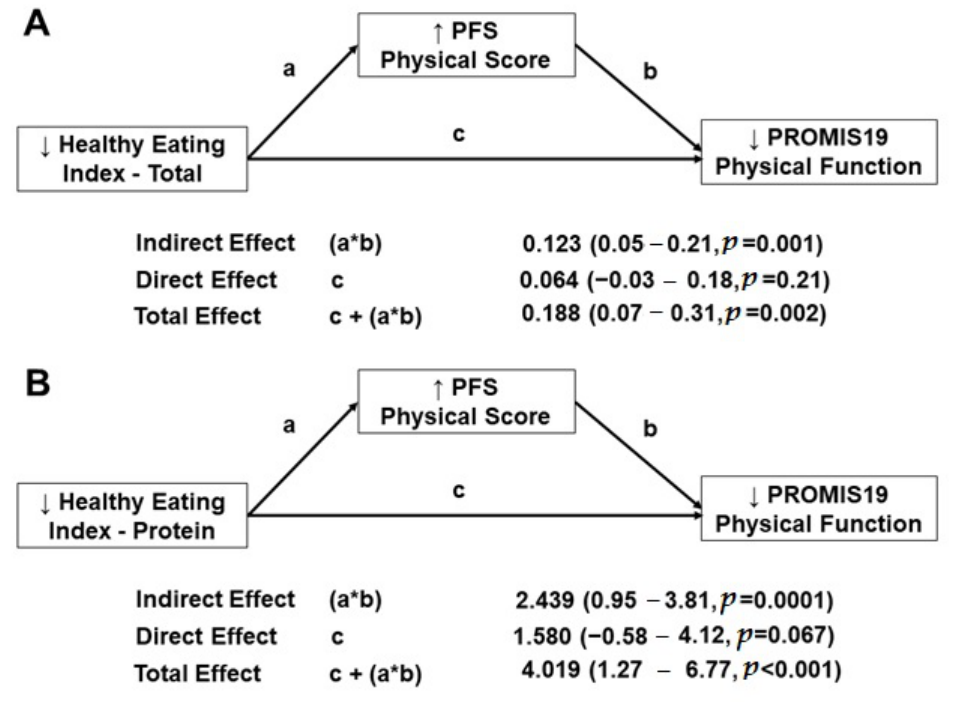
Figure 2. ( A ) shows the statistical mediation analysis for the associations of the lower Healthy Eating Index, more self- reported physical fatigability, on lower self-reported physical function through in a subset of 122 oldest-old participants from the Geisinger Rural Aging Study. ( B ) shows the statistical mediation analysis for the associations of the lower Healthy Eating Index—protein, more self-reported physical fatigability, on lower self-reported physical function through in a subset of 122 oldest-old participants from the Geisinger Rural Aging Study. The dependent (outcome) variable was set as the PROMIS19 Physical Function score, while the independent variable was set as the HEI total ( A ) or HEI protein ( B ), and the mediating variable was set as the Pittsburgh Fatigability Scale (PFS) Physical score. The models were also adjusted for the age group, sex, BMI, and the total number of medical conditions. The 95% confidence intervals (95% CI) were based on bootstrapping (1000